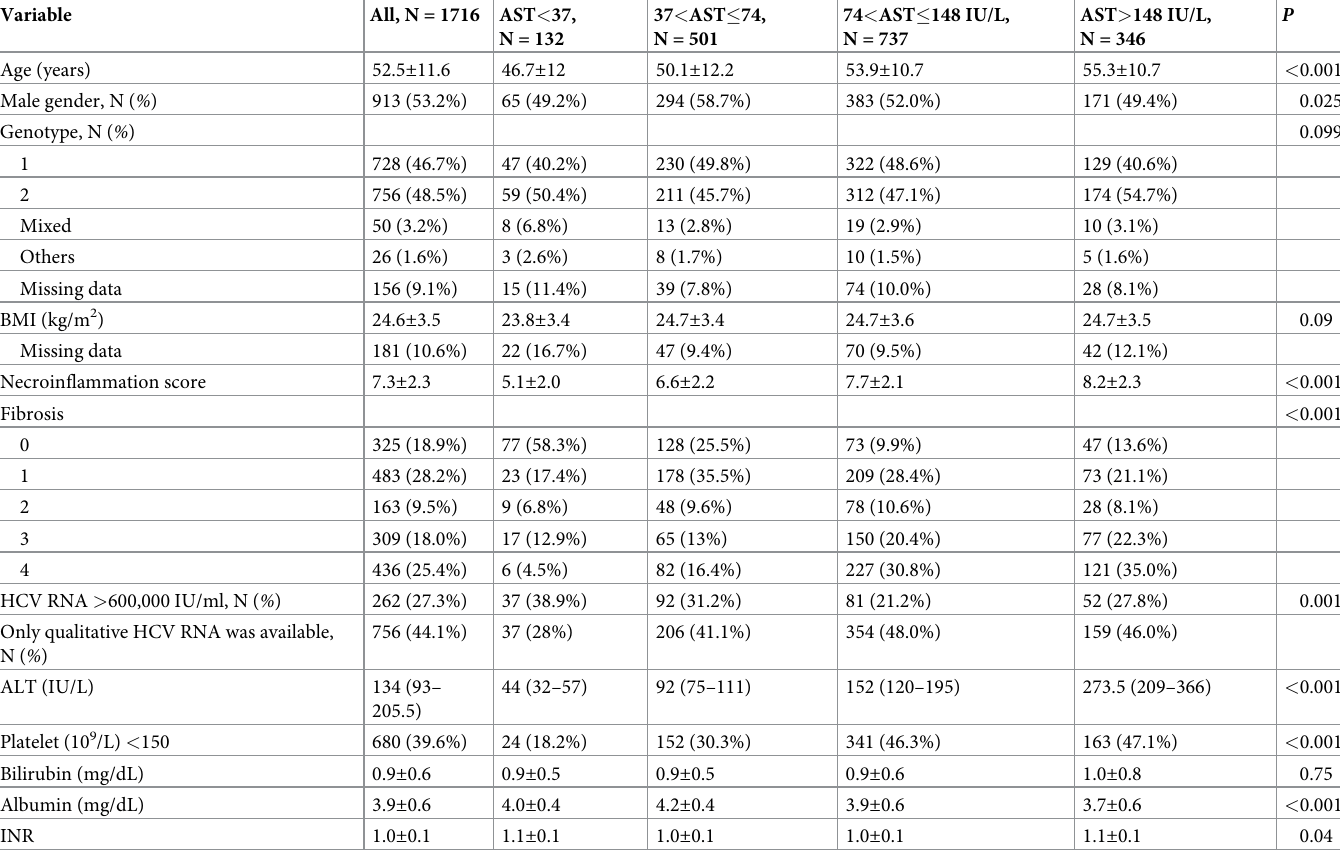
Table 1. Comparsion of patients according to AST